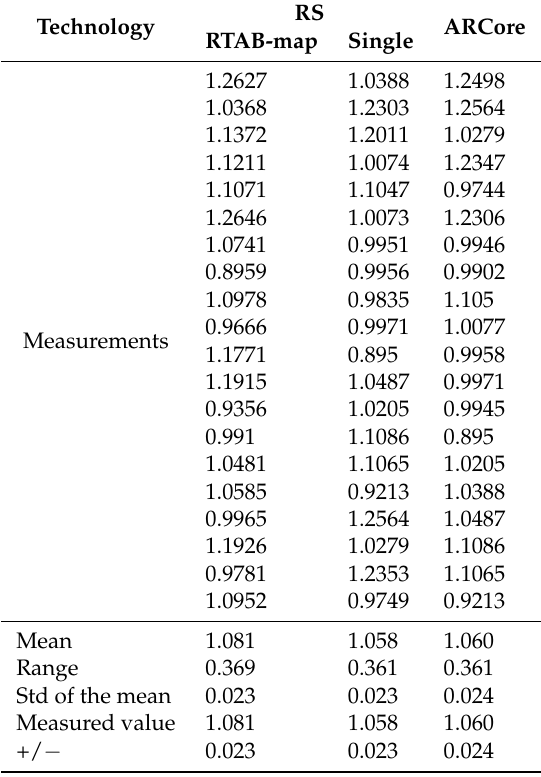
Table 1. Results of the reference